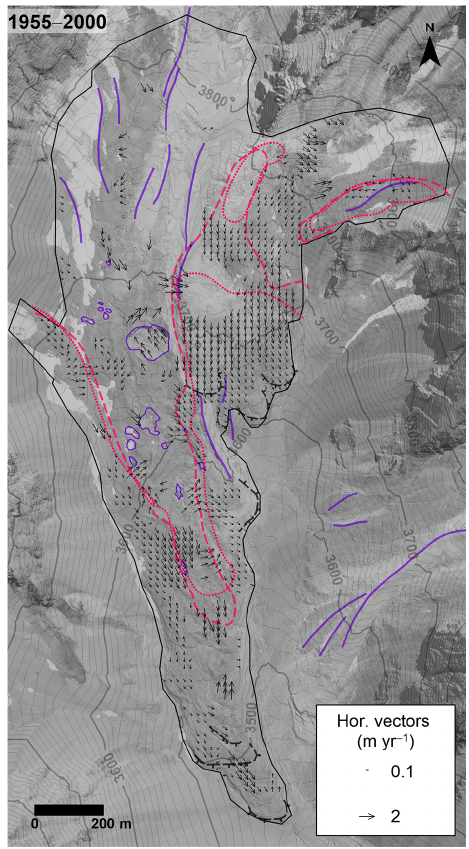
Figure 10. Horizontal displacements and elevation changes at the surface of Navarro between 2000 and 2014. The boundary be- tween debris-covered and rock glacier morphology is depicted with a dashed red line in 2000 and with a continuous red line in 2014. Note that moraine crests and thermokarst depressions in 2014 are indicated. The background of the map is the 2014 Geoeye